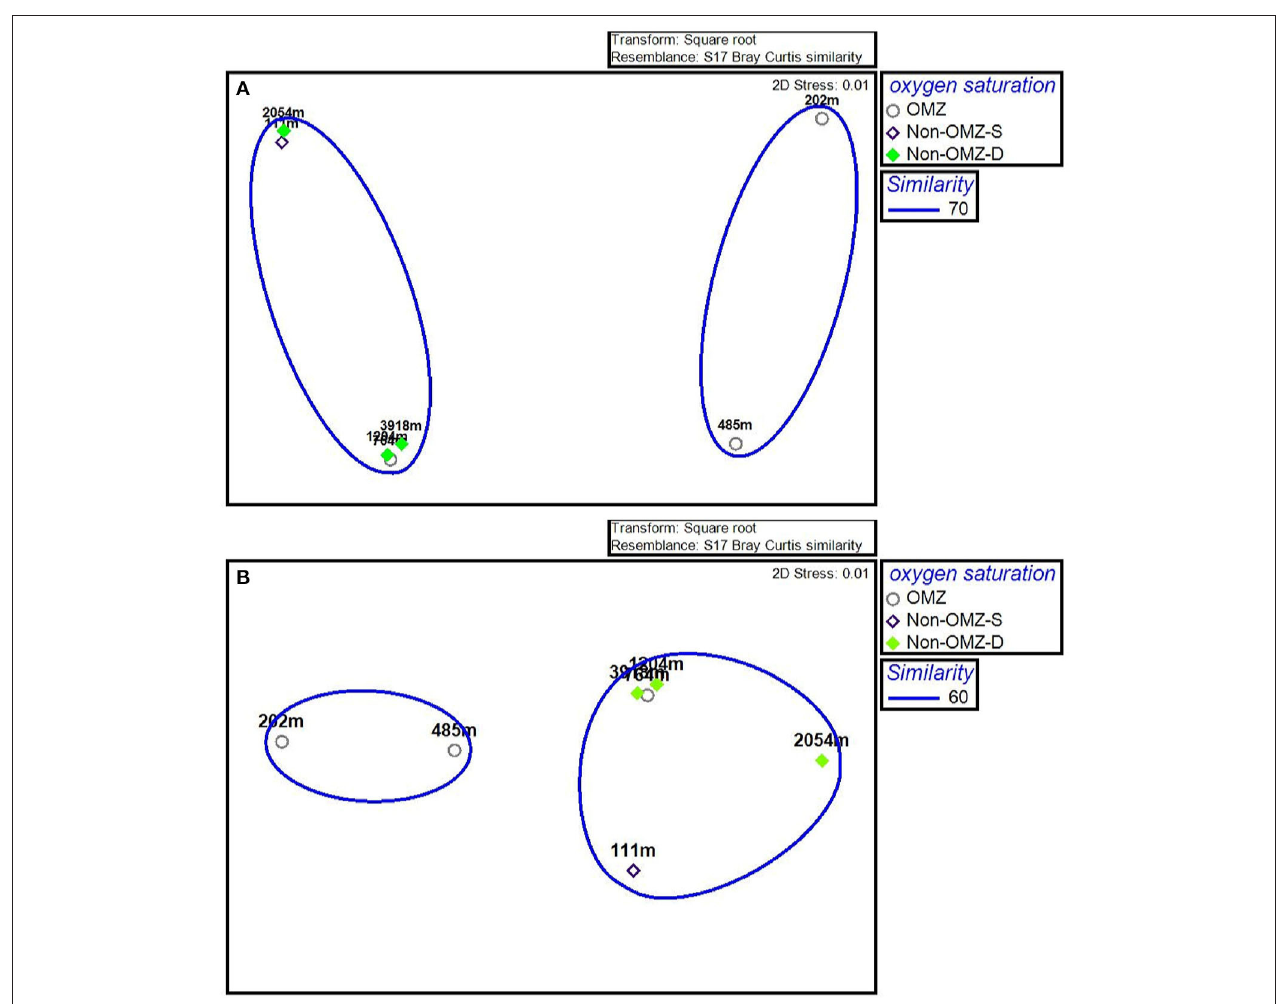
FIGURE 7 | The n-MDS ordination depicting the meiofaunal community on the WICM. (A) Meiofaunal density grouped on 70% similarity and (B) Meiofaunal biomass grouped on 60%